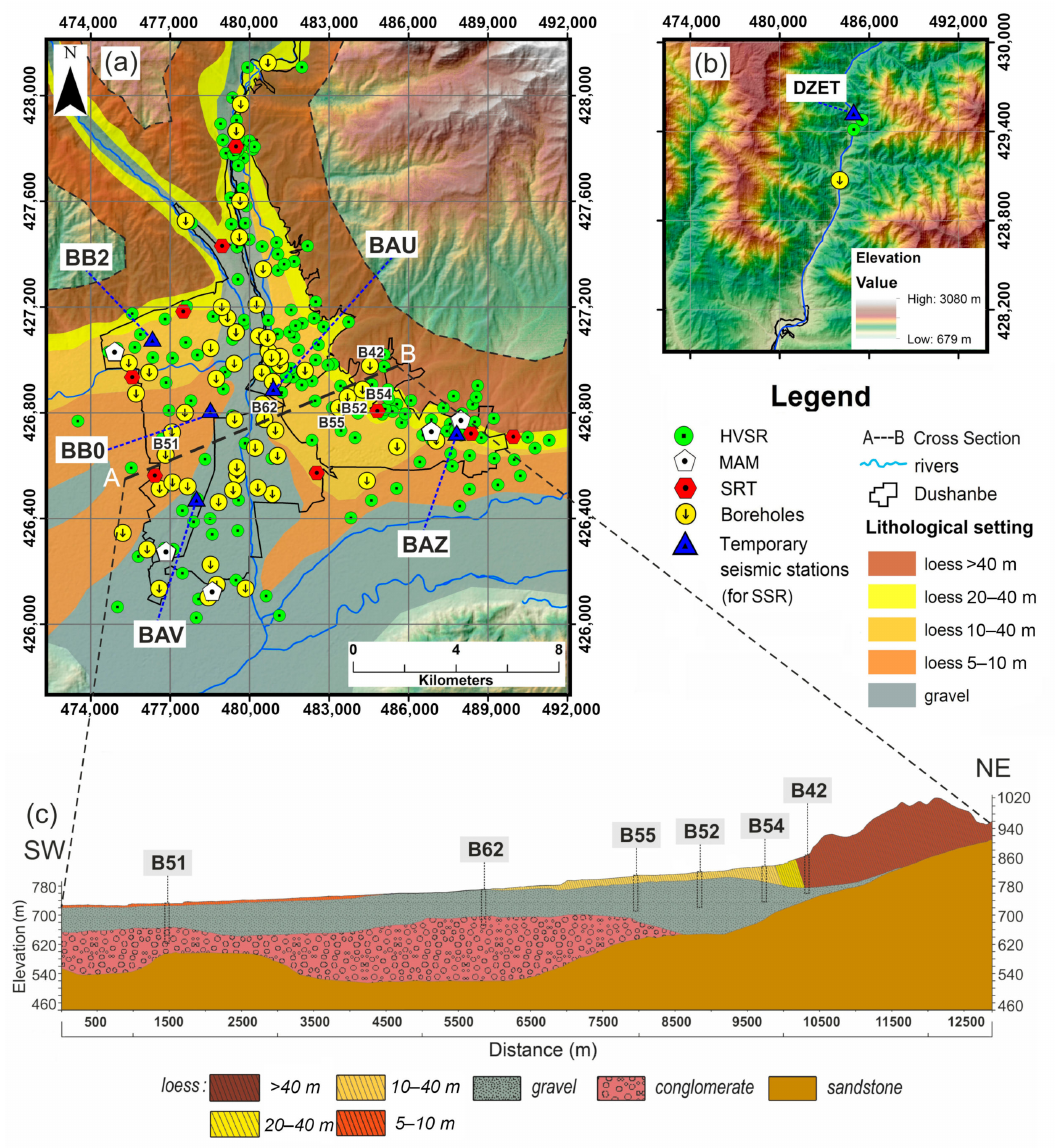
Figure 3. Locations of 60 boreholes, 5 microtremor array measurements (MAM), 9 seismic refraction tomography (SRT) profiles, 5 temporary seismic stations for standard spectral ratio (SSR) measurements, and 175 mobile seismic stations for horizontal to vertical spectral ratio (HVSR) measurements ( a ). The permanent seismic station Djerino (DZET, located in ( b ) serves as reference and is installed on a granite bedrock outcrop some 14 km north of Dushanbe (maps with hill shade and colored shuttle radar topography mission digital elevation model, SRTM DEM, of 30 m resolution as the background). Lithological cross section cutting through Dushanbe from southwest to northeast along profiles sketched from available boreholes ( c ); after the Head Institute of Engineering and Technical Surveys of the State Construction Committee of Tajikistan [27,29]. The numbers in the cross section ( c ) indicate examples of borehole logs (Section